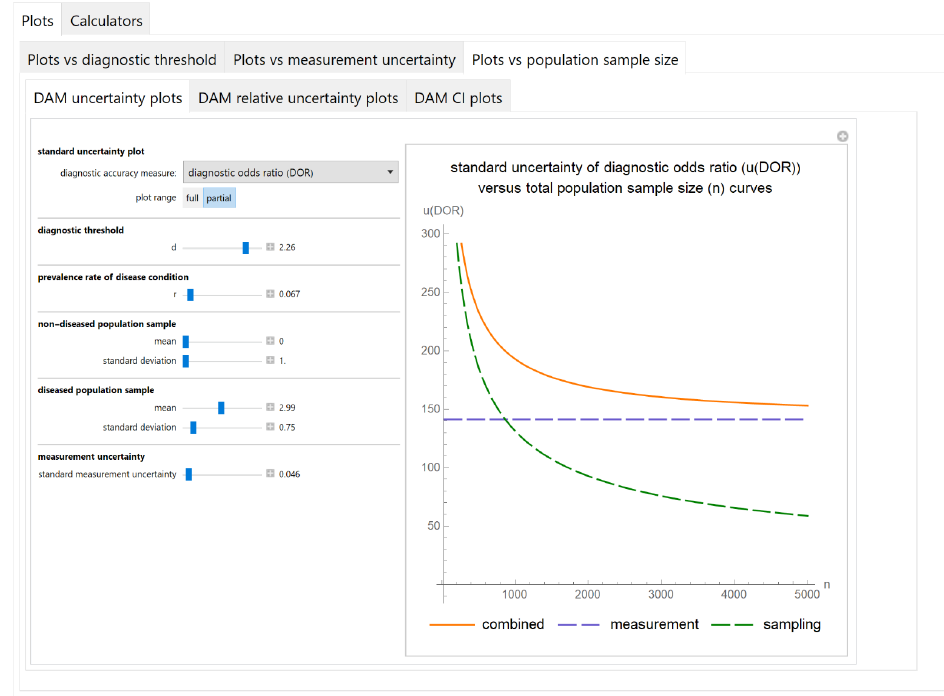
Figure 9. Plots vs. total population sample size module, DAM uncertainty plots submodule screenshot. Standard combined, measurement and sampling uncertainty of diagnostic odds ratio ( u(DOR) ) versus total population sample size ( n ) curves plot, with the settings shown on the left. The respective parameter settings are also shown in Table 3. Diagnostics 2021 , 11 , 406 Diagnostic Accuracy Measures Relative Standard Uncertainties Plots Submodule The values of the relative standard combined, measurement and sampling uncertain- ties of diagnostic accuracy measures of a screening or diagnostic test are plotted versus the total population sample size (Figure 10).